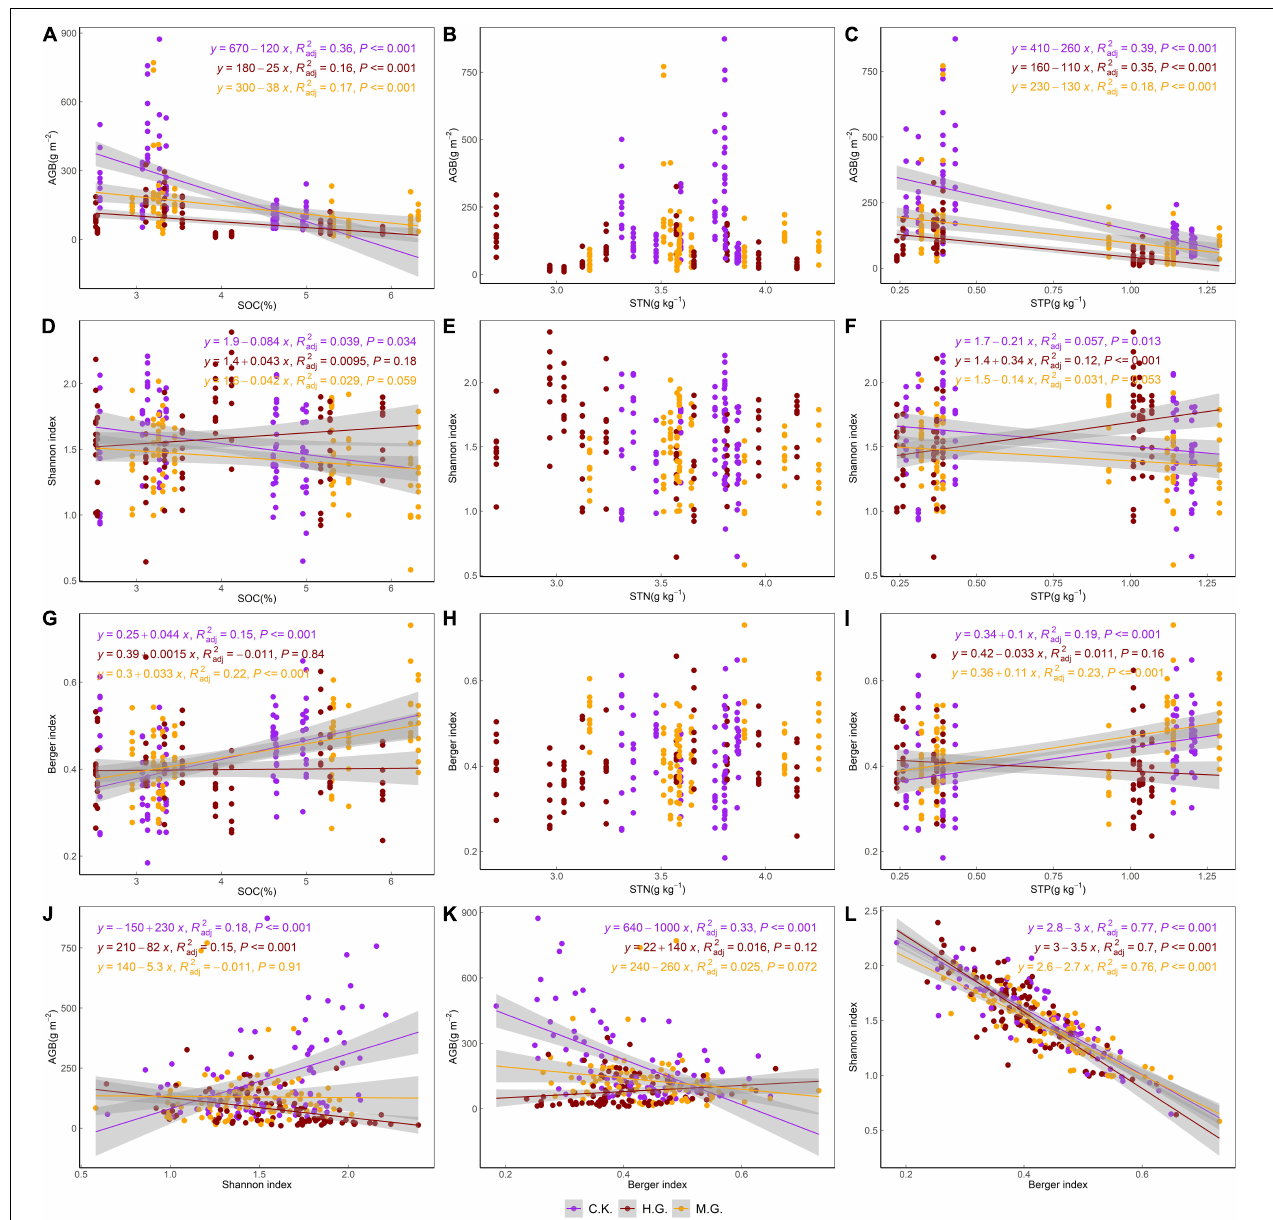
FIGURE 6 | (A–L) The changing pattern of biodiversity indices, soil nutrients, and aboveground biomass at three treatments. The three treatments include grazing exclusion (C.K.), moderate grazing (M.G.), and heavy grazing (H.G.). The color purple represents C.K., the color orange represents M.G., and the color dark red represents H.G.,